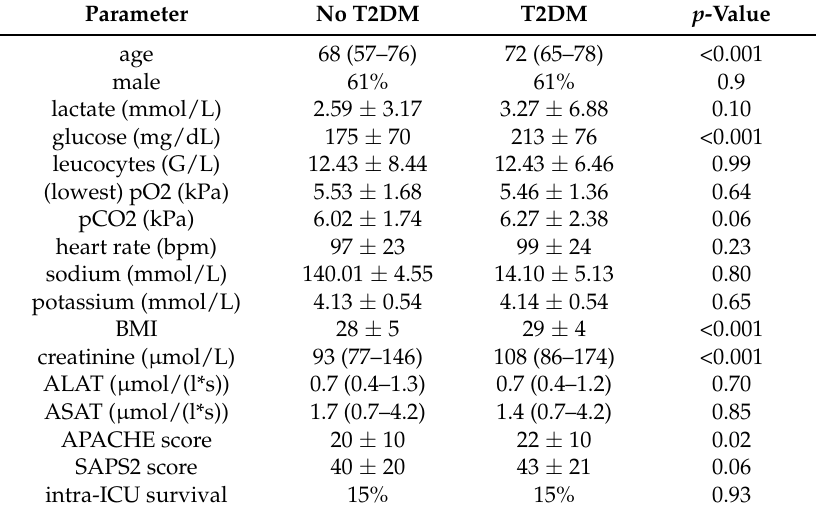
Table 7. In the overall cohort, patients with a medical history of diabetes (12%) were sicker in trend (SAPS2 score 43 ± 21 vs. 40 ± 20; p = 0.06) and older (72 (65–78) vs. 68 (57–76) years; p < 0.001). Parameter No